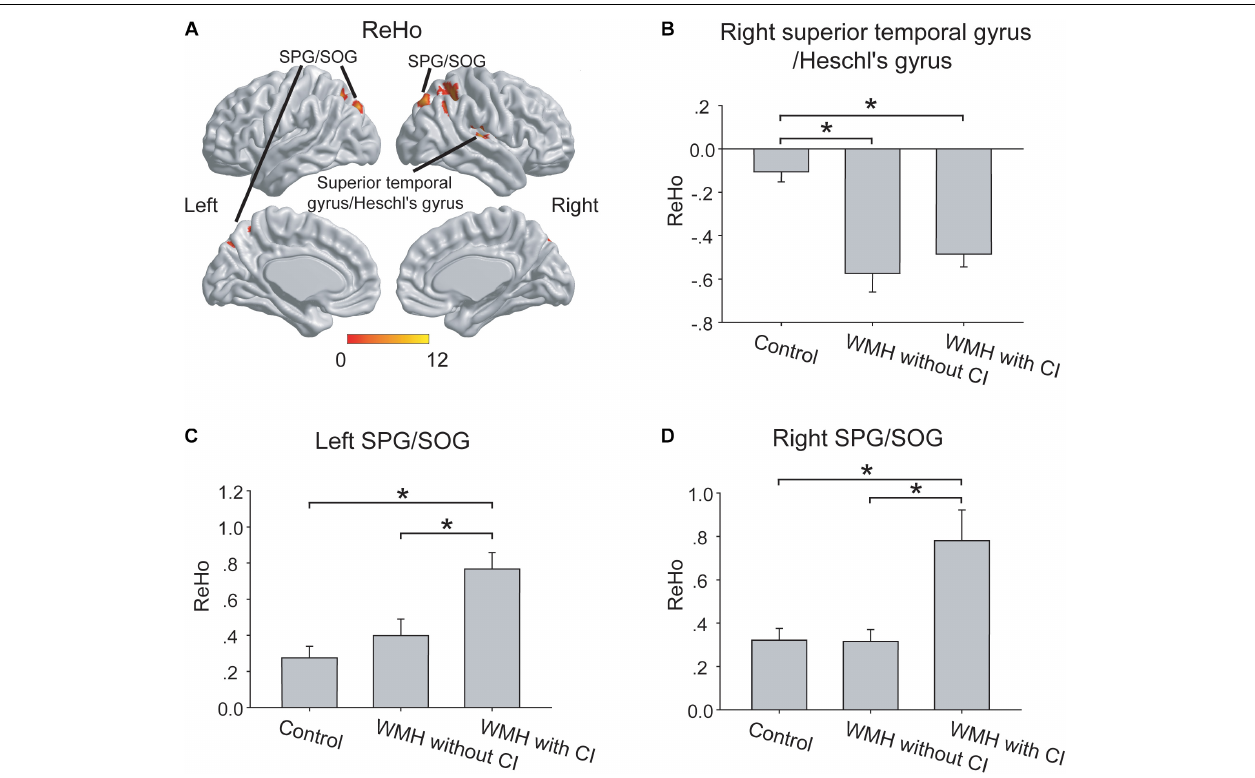
FIGURE 2 | The group differences of ReHo. (A) The group differences of ReHo were shown in the right superior temporal gyrus/Heschl’s gyrus, left SPG/SOG and right SPG/SOG. (B) In the right superior temporal gyrus/Heschl’s gyrus, both the WMH with CI group and the WMH without CI group displayed lower ReHo than the control group. (C,D) In the left SPG/SOG and right SPG/SOG, the WMH with CI group showed higher ReHo than both the WMH without CI group and the control group. ReHo values have been normalized by subtracting the mean voxel-wise ReHo obtained for the entire brain, and then dividing the resultant value by the standard deviation. The thresholds were set at a corrected P < 0.01, determined by Monte Carlo simulation for multiple comparisons (voxel-wise P < 0.01, FWHM = 6.9 mm, cluster size > 1782 mm 3 ). The color bars are presented with F -values. ∗ P < 0.05, CI, cognitive impairment; ReHo, Regional Homogeneity; SPG, superior parietal gyrus; SOG, superior occipital gyrus; WMH, white matter